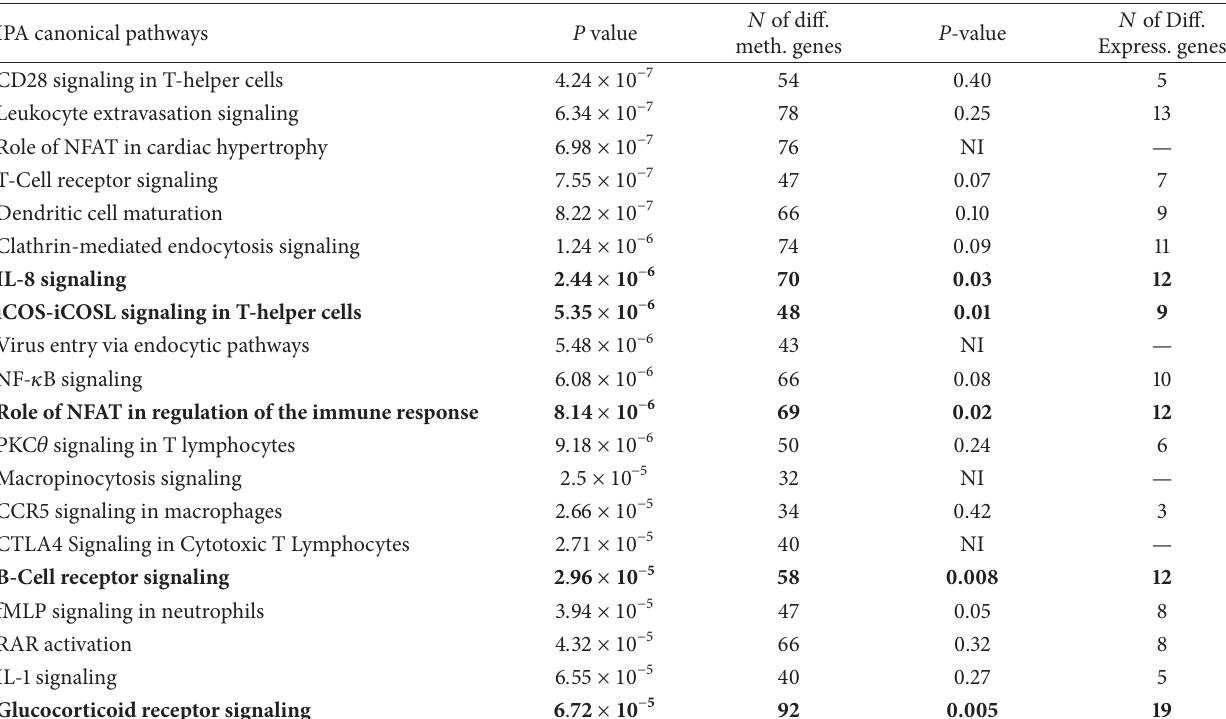
Table 2: Comparison of the top 25 overrepresented canonical immune/inflammatory pathways identified from differential methylation and expression analyses between BMS and AMS